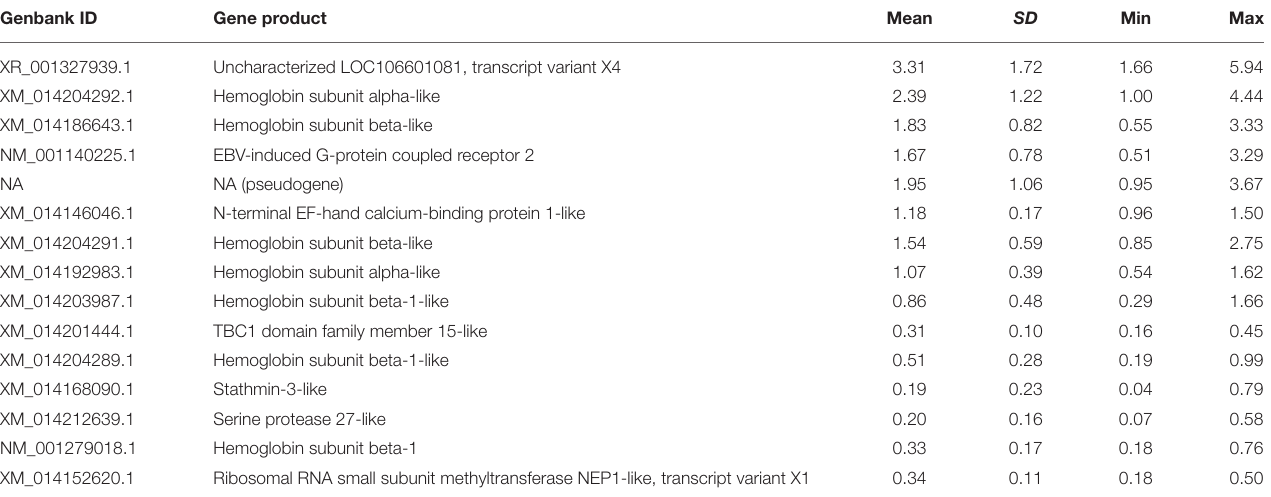
TABLE 1 | Read percentages for the 15 most abundant genes in the erythrocyte samples. Genbank ID